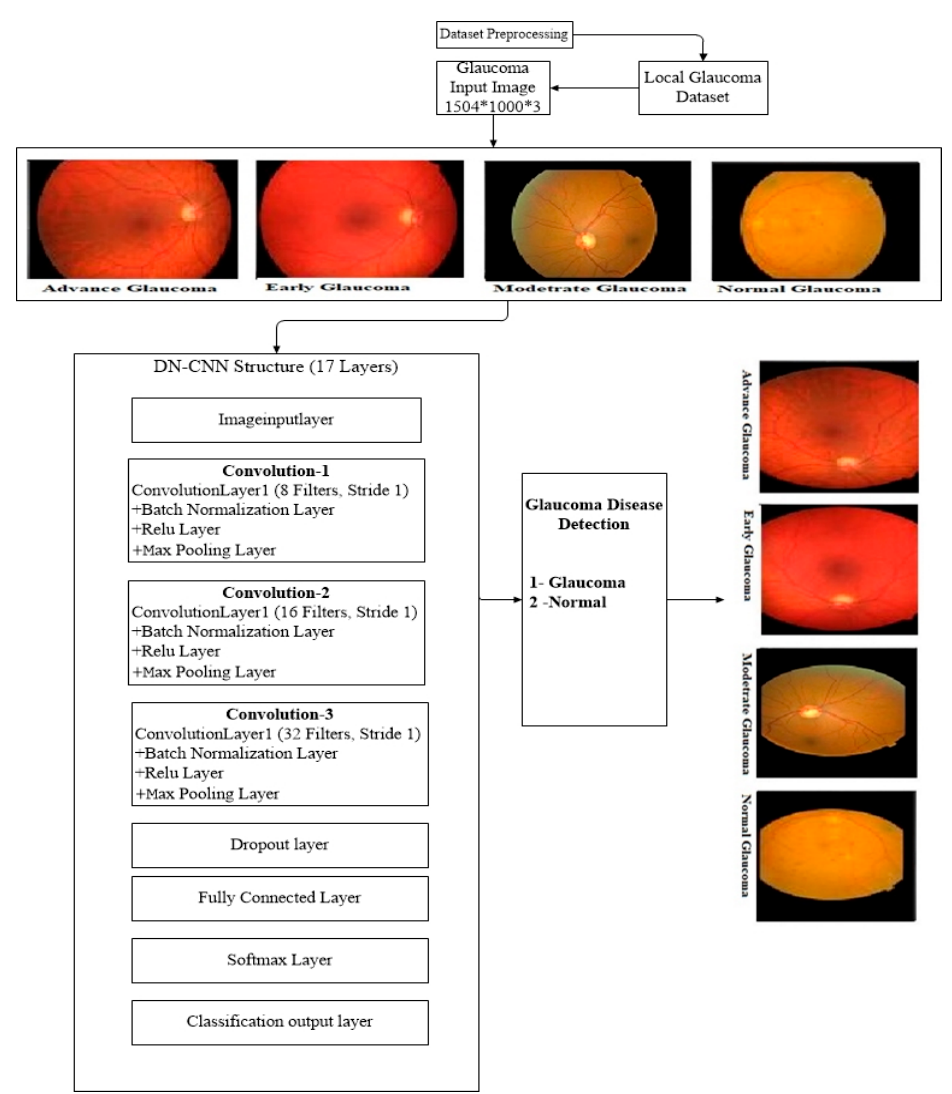
Figure 3. Layer-Wise Representation of the Architecture of Detection-Net-CNN. Table 1. Description of Layers of Detection-Net Convolutional Neural Network (DN-CNN). CNN Layers Description with Learning Rate = 0.001 and Epochs = 60 Sr.